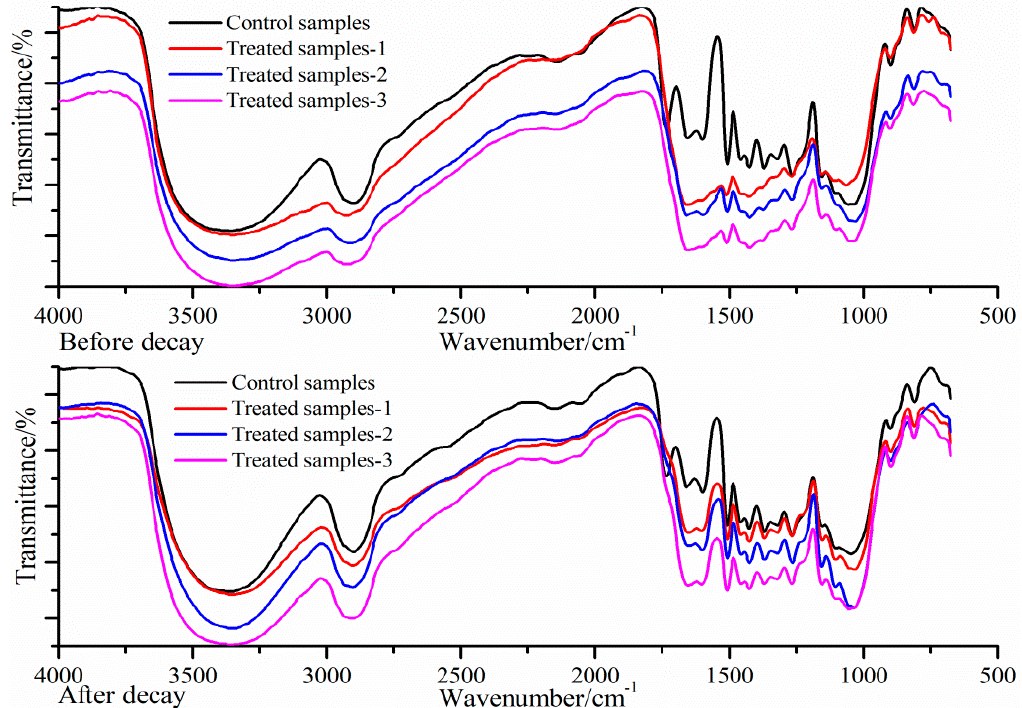
Figure 1. Fourier transform infrared (FTIR) spectrum of wood samples before/after decay.